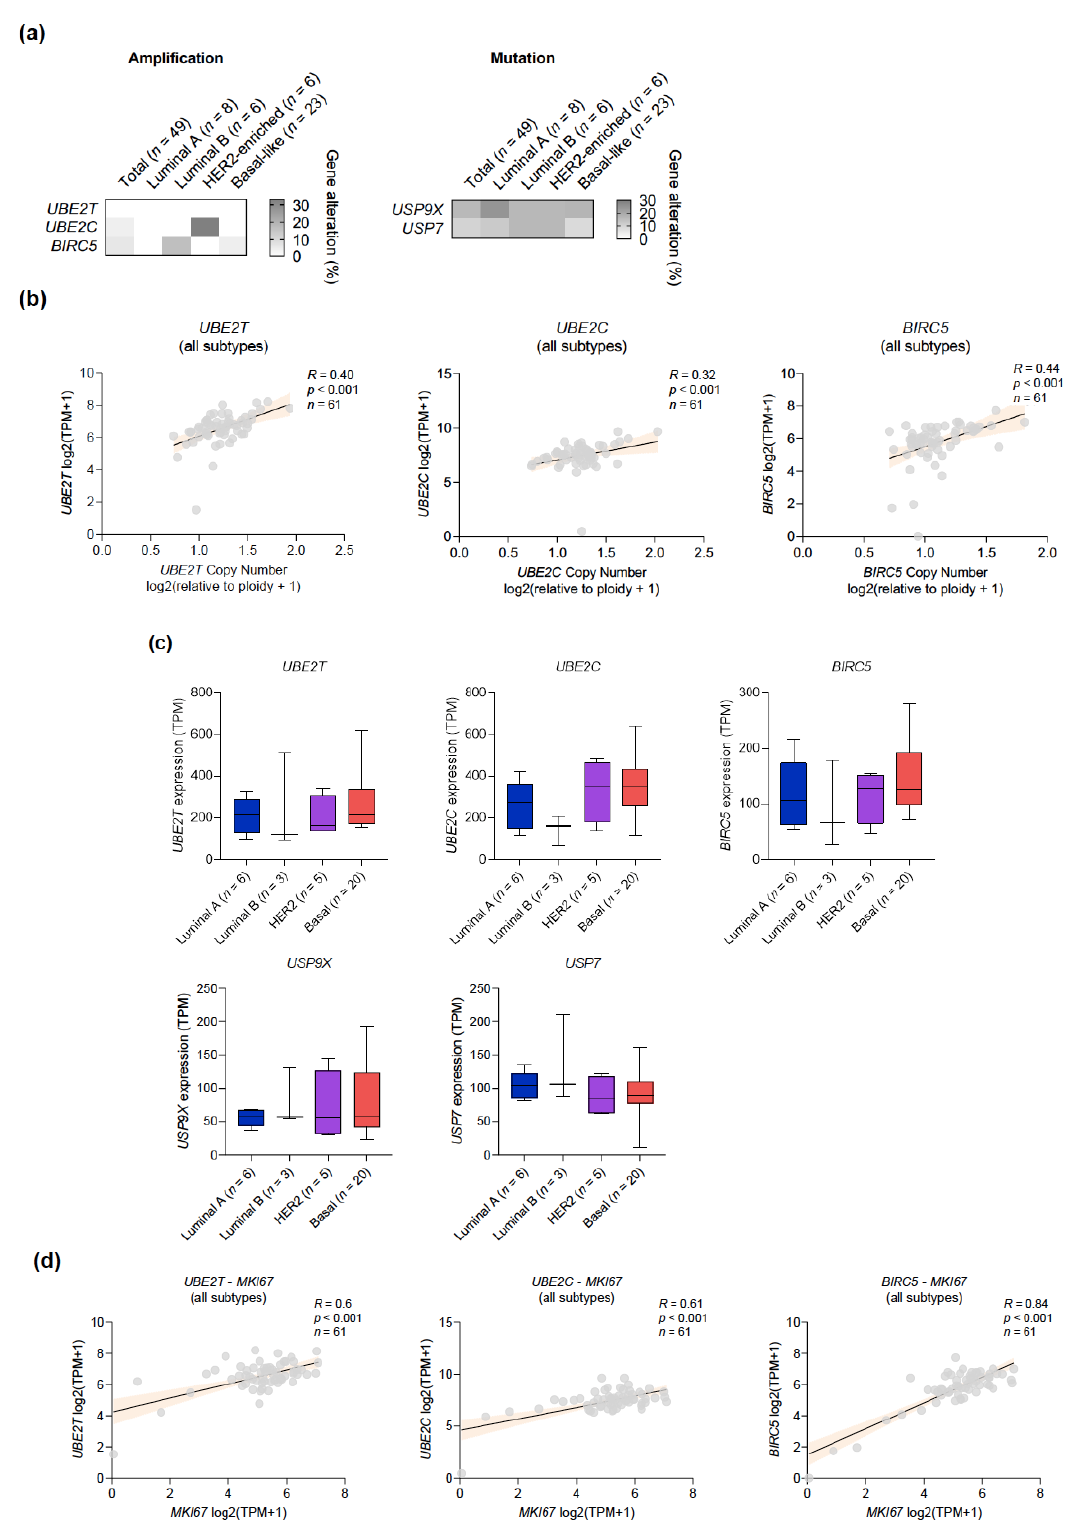
Figure 8. In vitro correlates of the genomic vulnerabilities identified in the SUN machinery in BC. ( a ) Heatmap showing the frequency of UBE2T , UBE2C , and BIRC5 amplifications, and USP9X and USP7 mutations, across cell lines of different intrinsic subtypes. ( b ) Positive dependance between copy number and gene expression in BC cell lines. ( c ) Distribution of gene expression across cell lines of the different intrinsic subtypes. ( d ) Positive correlation between the expression levels of UBE2T , UBE2C , and BIRC5 , and proliferation marker MKi67 .